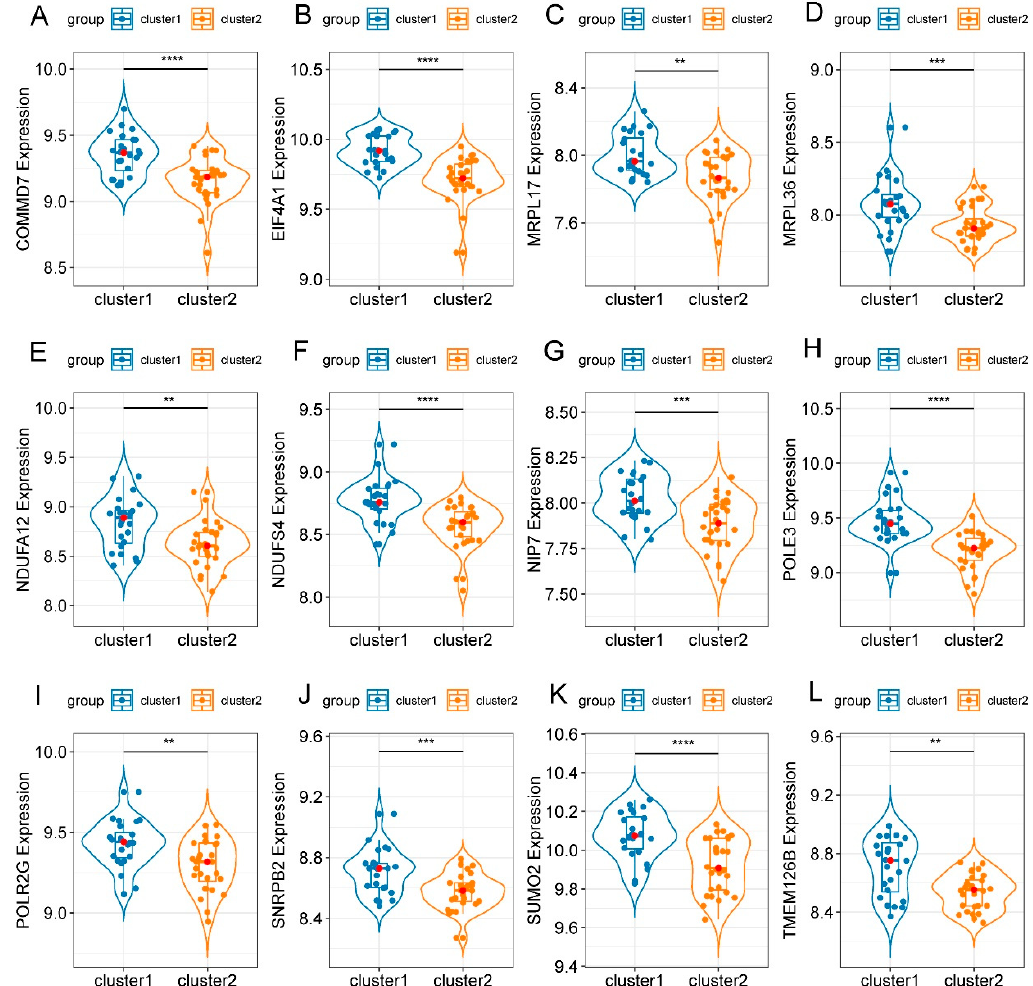
Figure 8. Violin diagrams demonstrate the expression levels of hub genes in the two clusters. ( A – L ) The expression levels of the 12 hub genes were consistently higher in cluster 1 than in cluster 2. The asterisks indicate that the differences are statistically significant. ** p < 0.01, *** p < 0.001, **** p < 0.0001.